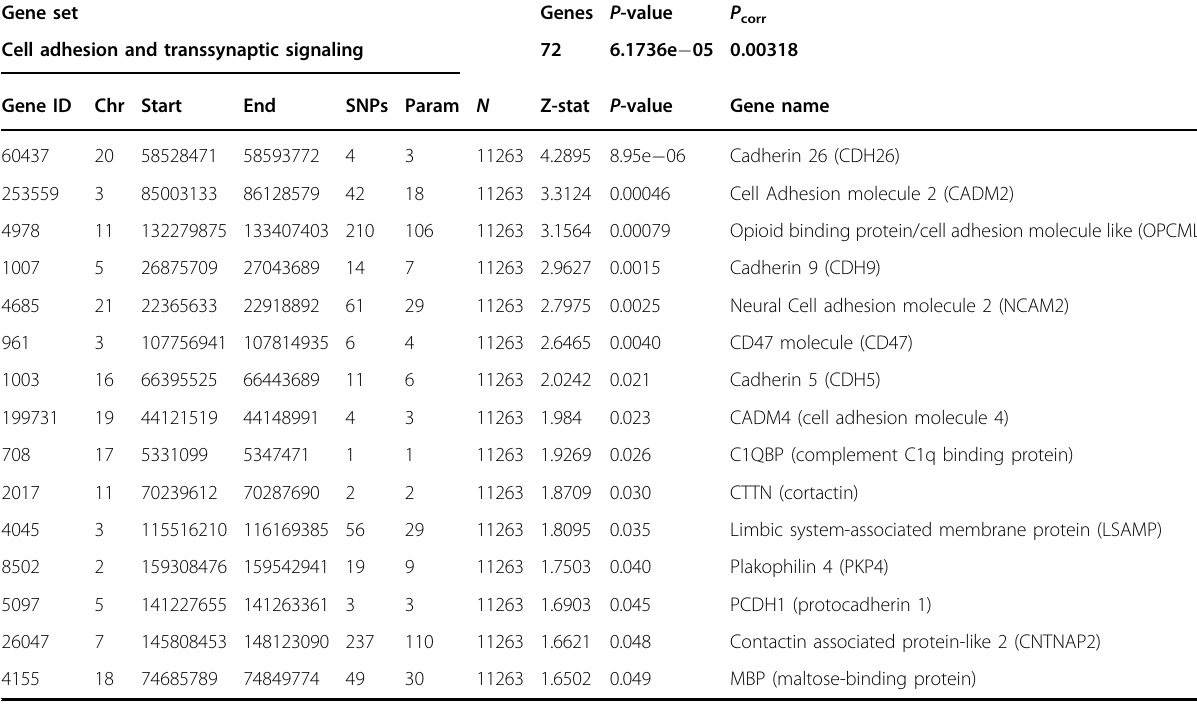
Table 1 Statistically signi fi cant result of MAGMA gene set analysis. Gene set Genes P -value P corr Cell adhesion and transsynaptic